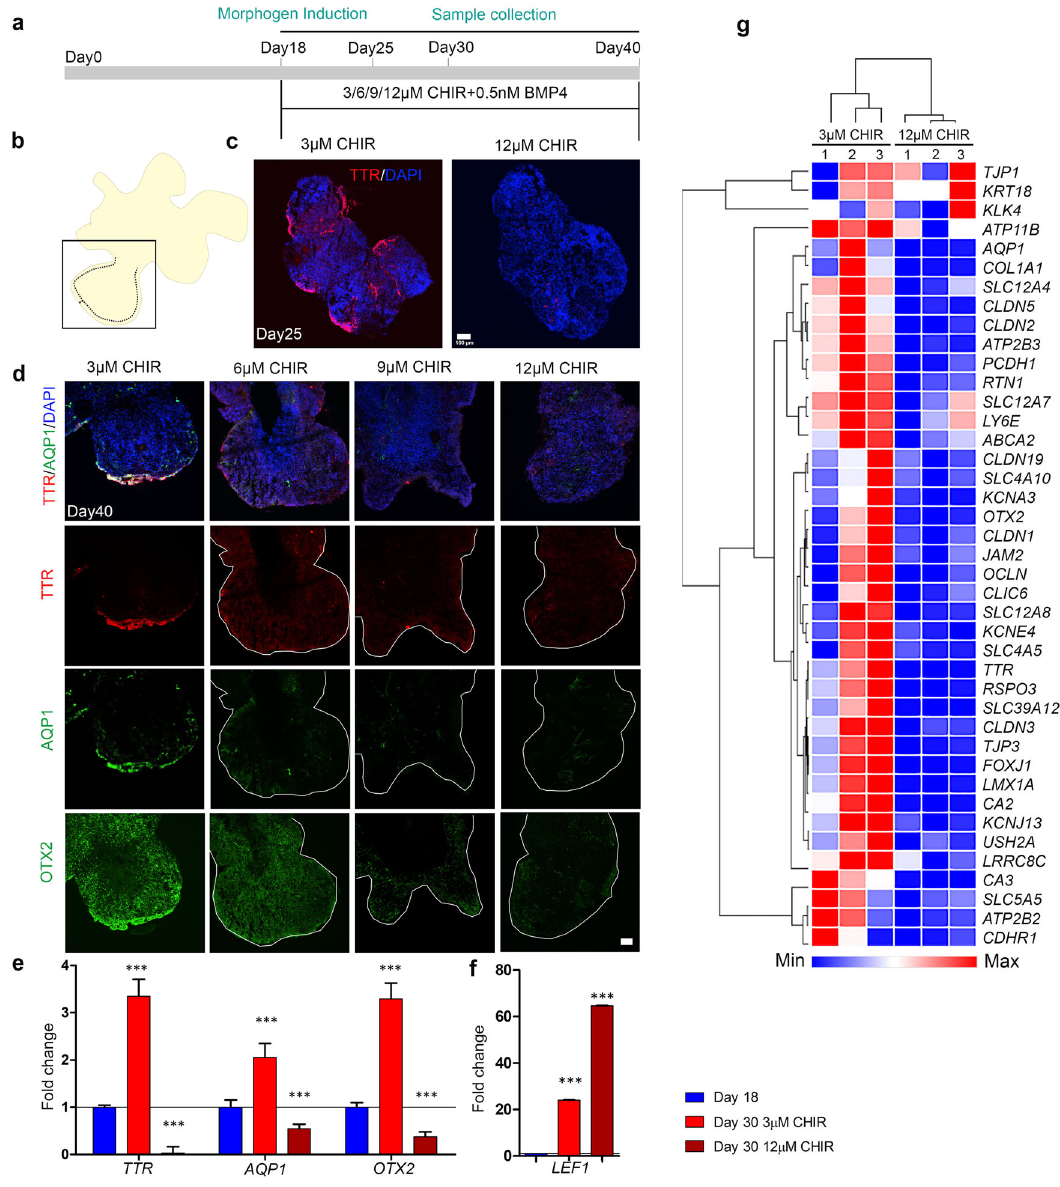
Fig. 10 High activation of the canonical Wnt pathway in hESC-derived organoids causes suppression of ChPe markers. a A schematic presentation of the protocol for the treatment of organoids with the canonical Wnt agonist CHIR. b , c The ChP marker TTR is present in the periphery of a day 25 organoid exposed to 3 μ M, but not when exposed to 12 μ M CHIR, from day 18. c N = 4 organoids (3 μ M CHIR) and 5 organoids (12 μ M CHIR treated); were used for immunohistochemistry analysis. d High magni fi cation images (boxed region shown in b) of serial sections of a day 40 organoid exposed to 3 μ M reveal the presence of TTR, AQP1, and OTX2 in the periphery. This labeling is reduced or undetectable upon exposure to higher concentrations of CHIR (6/9/12 μ M).